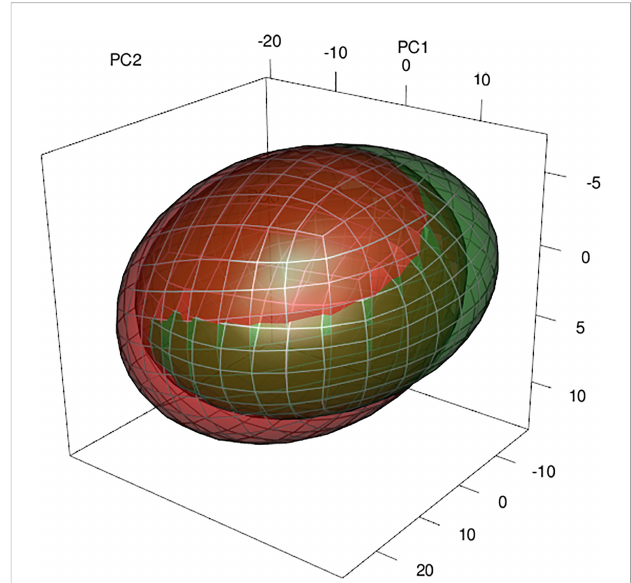
FIGURE 2 Representation of the environmental niches of both species through ellipsoids and the overlap between them. The 3-D space corresponds to the three fi rst principal components calculated with the same environmental variables used in the niche models. In red A. melanoxylon , green A. dealbata .